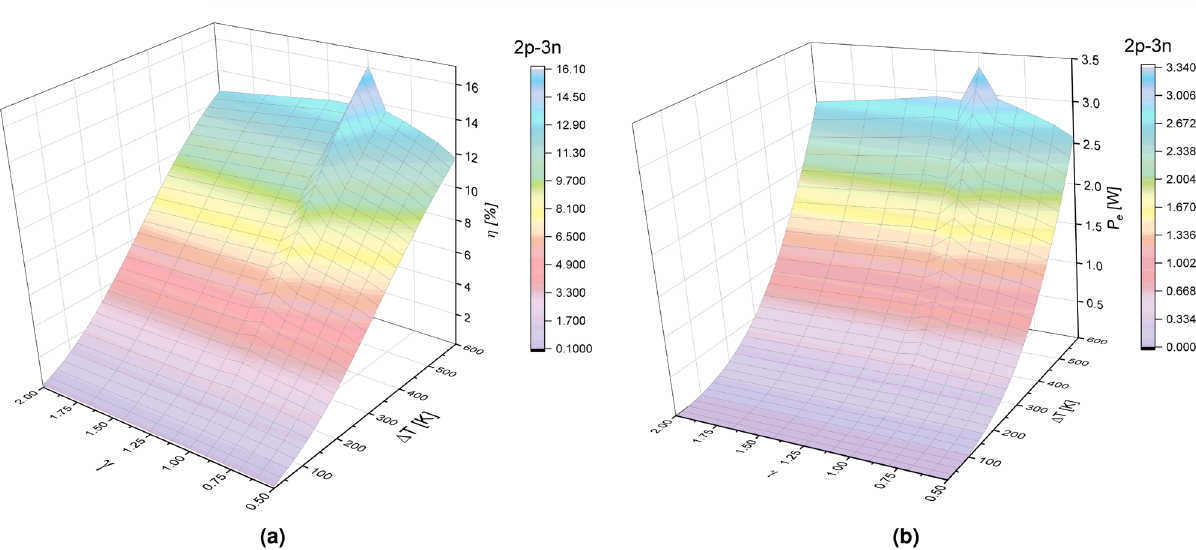
Figure 6. ( a ) Efficiency (η) and ( b ) Output power ( P e ) in function of geometric factor (γ) and temperature difference (� T ) for a TEG in the 3p-2n segmentation at R L = 5.83 (cid:31) .